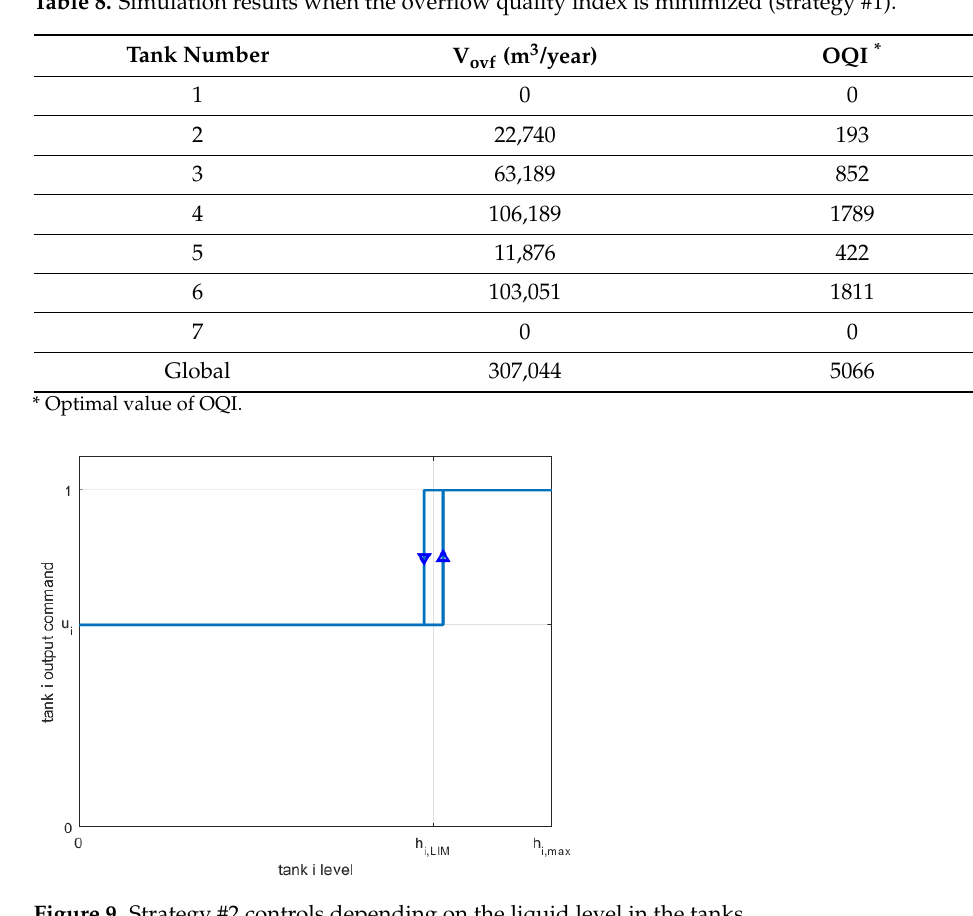
Table 8. Simulation results when the overflow quality index is minimized (strategy #1).